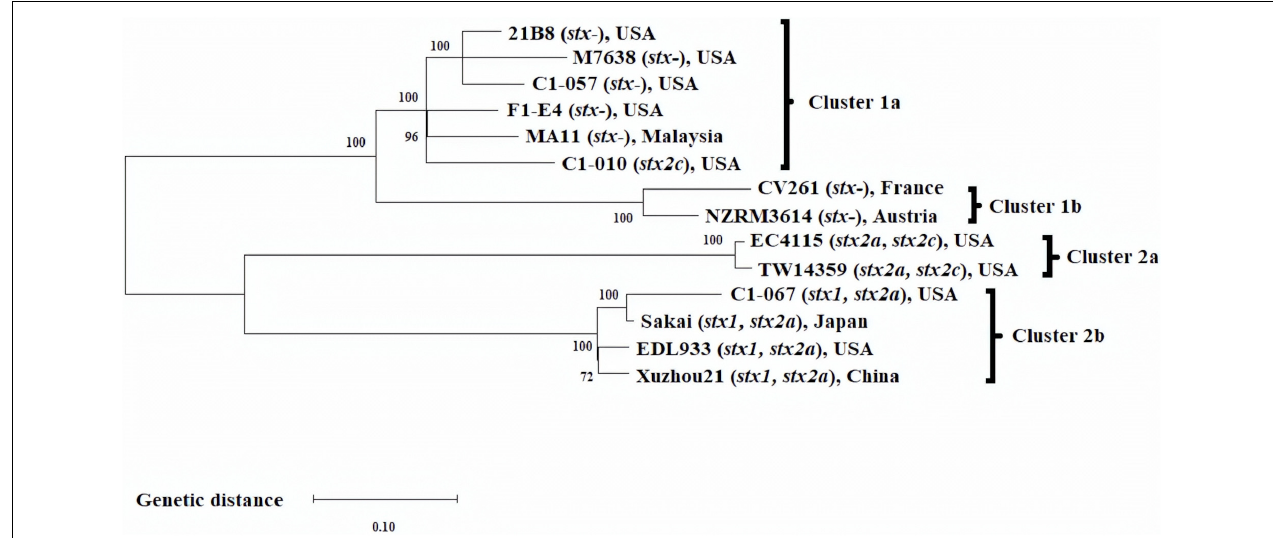
TABLE 3 | Different prophage contents, including intact, questionable, and incomplete prophages, predicted from the Escherichia coli O157:H7 strains belonging to Cluster 1 and Cluster 2 by PHASTER. E. coli O157:H7 strain stx profile Number of intact